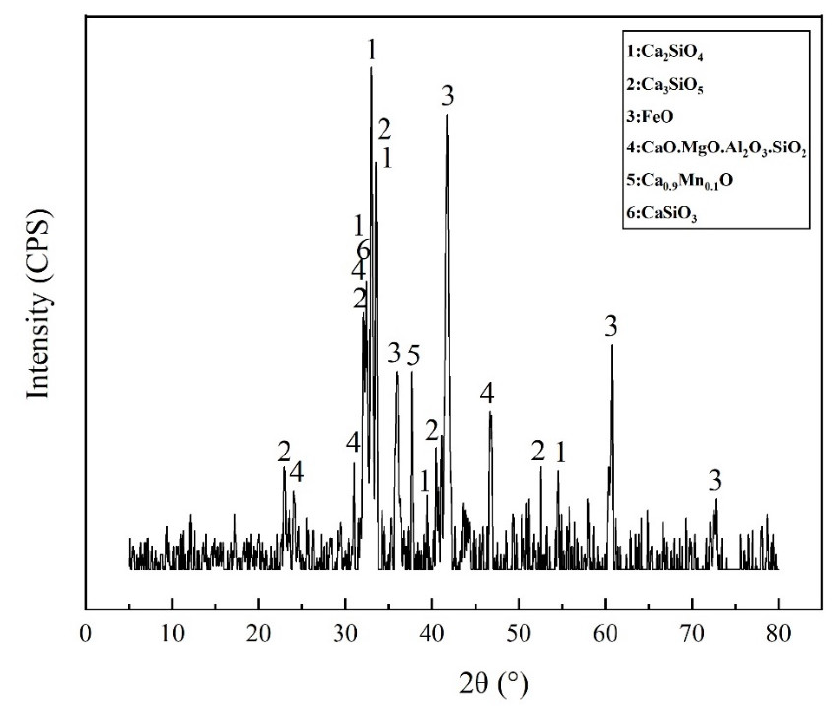
Figure 10. The XRD of SSP.